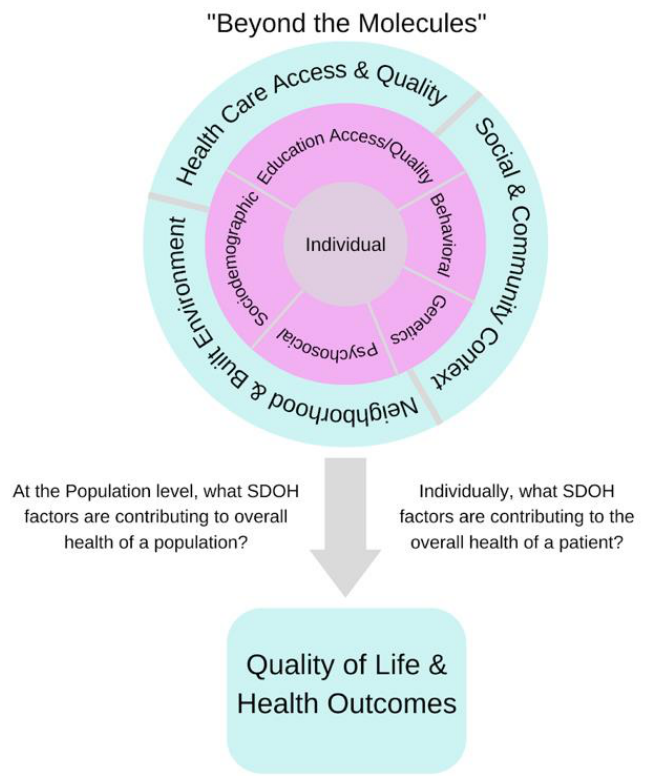
Figure 1. Grouped SDOH factors are categorized at the population and individual levels. At each level, we define the SDOH factors that contribute to the overall health of a population and the overall health of a patient, which mark the difference between a good outcome and a poor outcome.